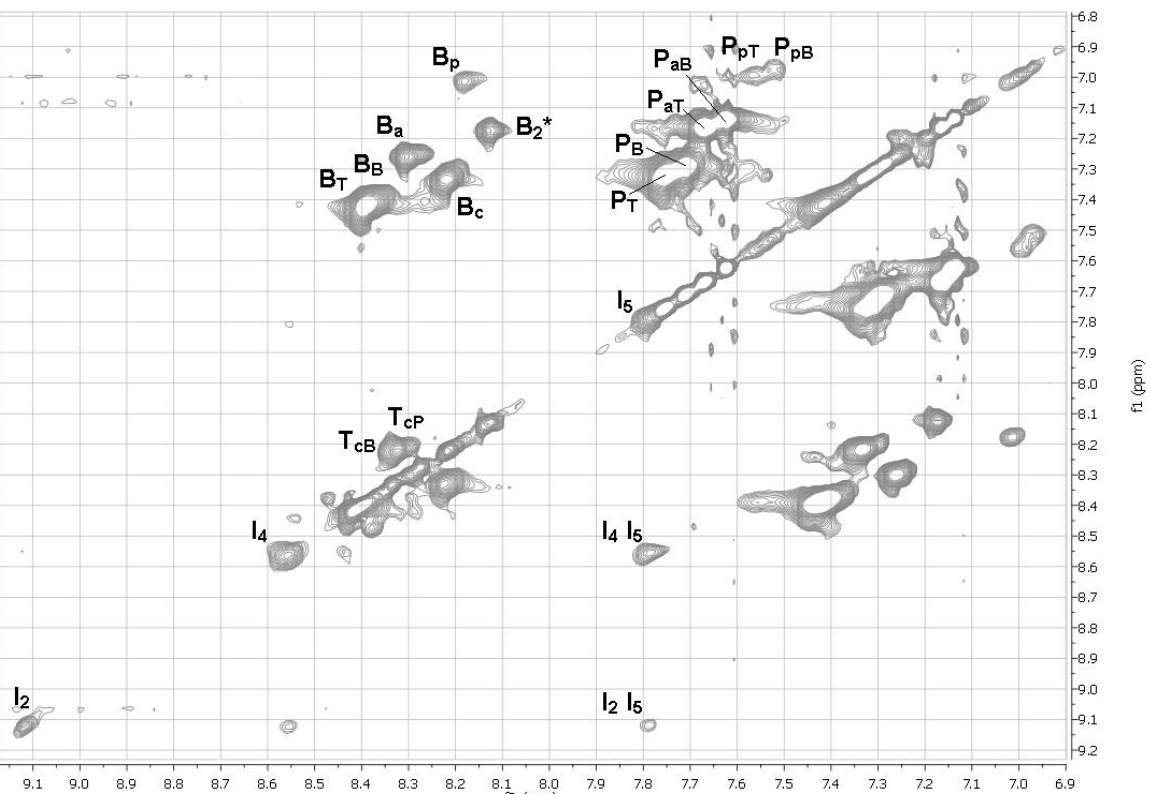
Figure 8. 1 H TOCSY NMR spectrum of HFIP extract of polymer